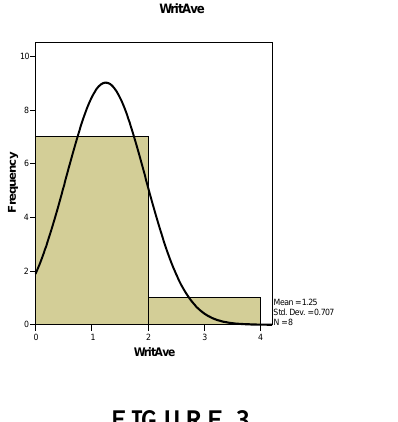
Histogram of the Writing Subtest Scores for Beginning Level ( N =8)